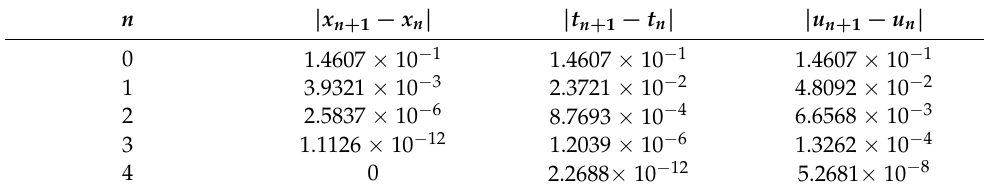
Table 3. Results for x 0 = 0.15 for Example 6.